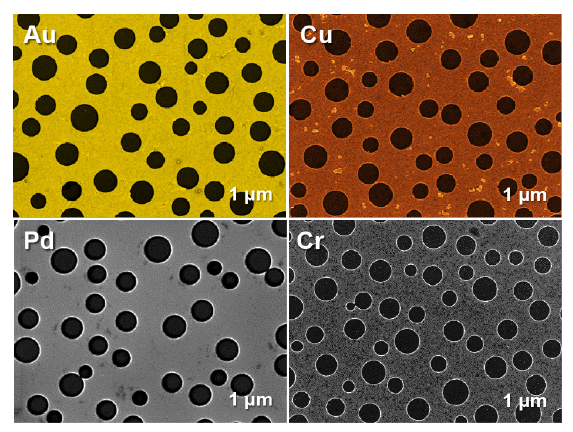
Figure 2: SEM images of perforated Au, Pd, Cu, and Cr films fabri- cated by metal PBL. Aluminum films are shown below in Figure 4.